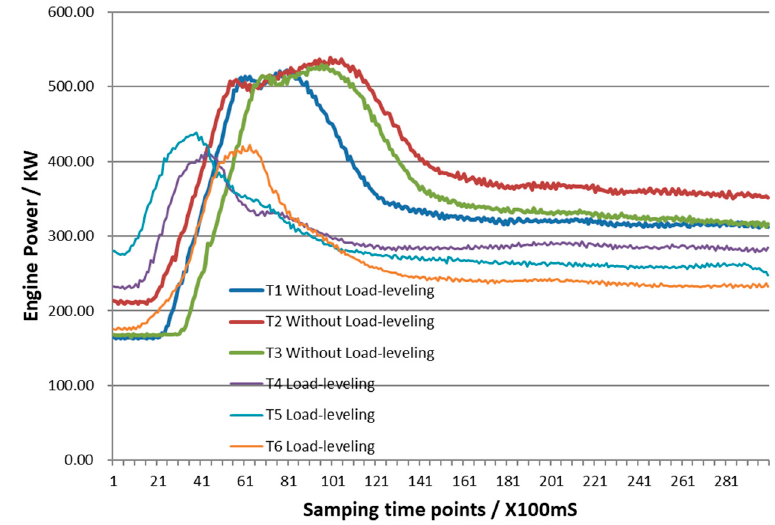
Figure 17. Power data of the engine.